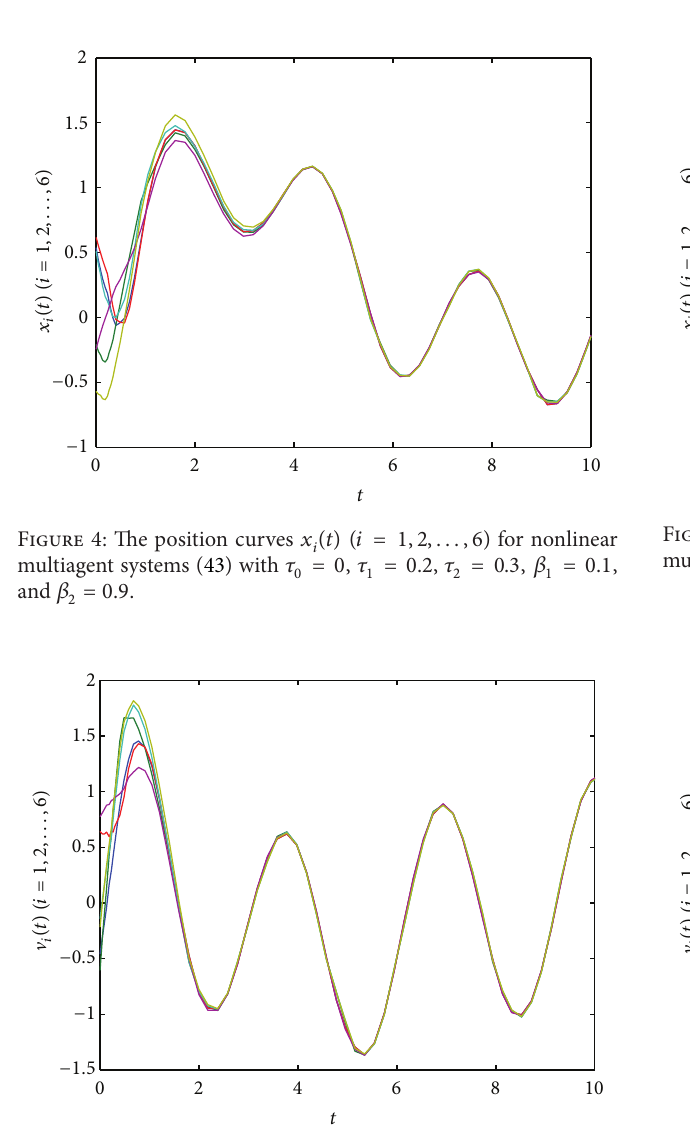
Figure 5: The velocity curves V 𝑖 (𝑡) (𝑖 = 1, 2, . . . , 6) for nonlinear multiagent systems (43) with 𝜏 0 = 0 , 𝜏 1 = 0.2 , 𝜏 2 = 0.3 , 𝛽 1 = 0.1 , and = 0.9 . 𝛽 2